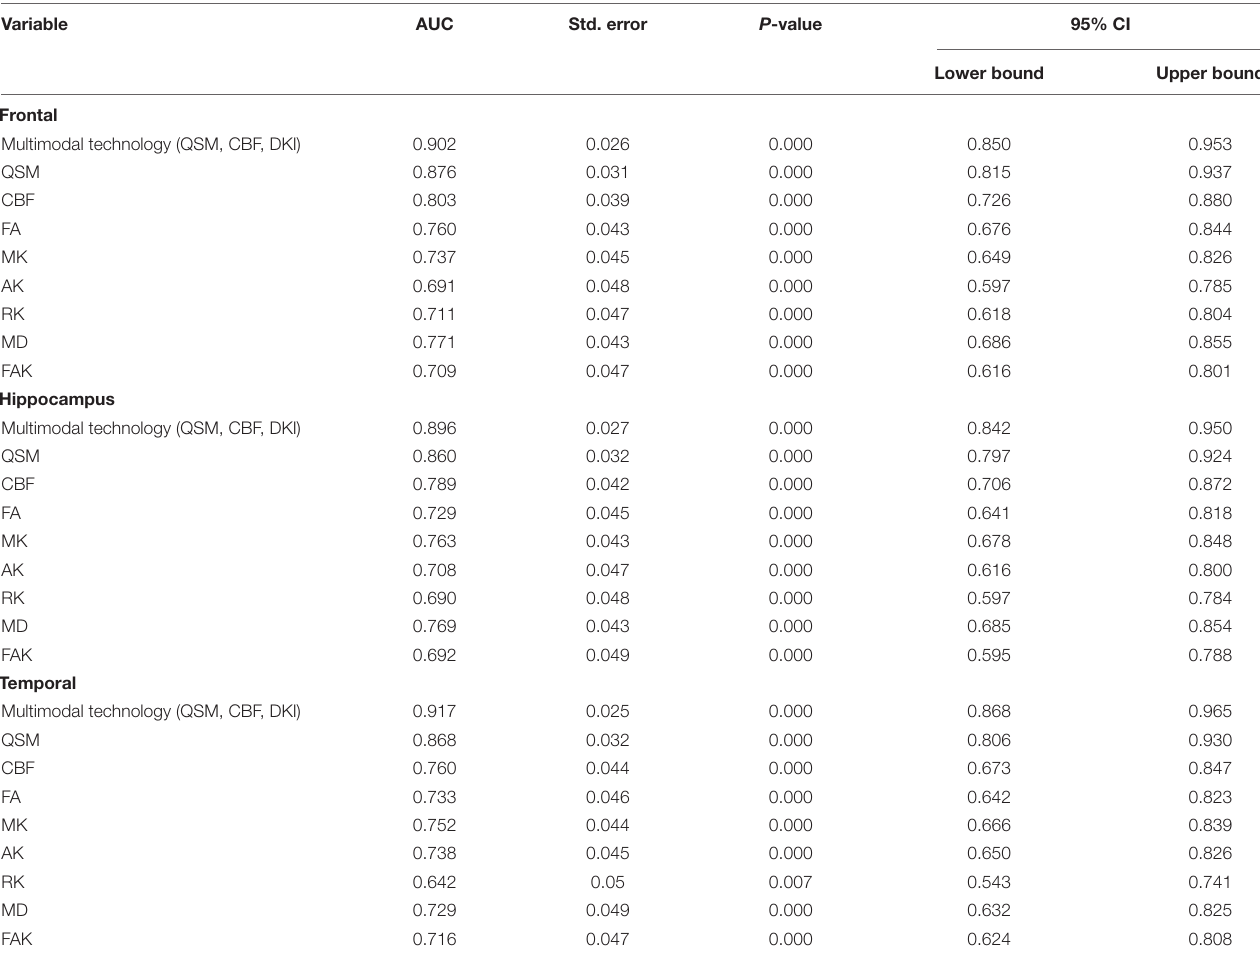
TABLE 5 | Receiver operating characteristic (ROC) curve analysis results of quantitative susceptibility mapping (QSM), cerebral blood flow (CBF), and diffusion kurtosis imaging (DKI) values in frontal lobe, temporal lobe and hippocampus ( n = 60). Variable AUC Std. error P -value 95% CI